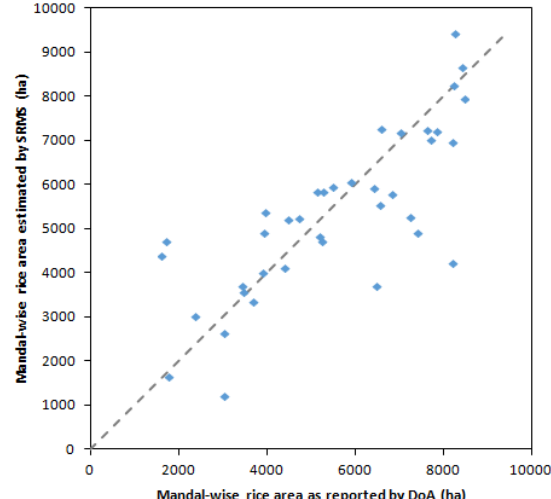
Figure 4. Comparison of mandal-wise rice area estimates with rice area from DoA, 2018 kharif , 11 September 2018. Indeed, Ranastalam and Laveru mandals show